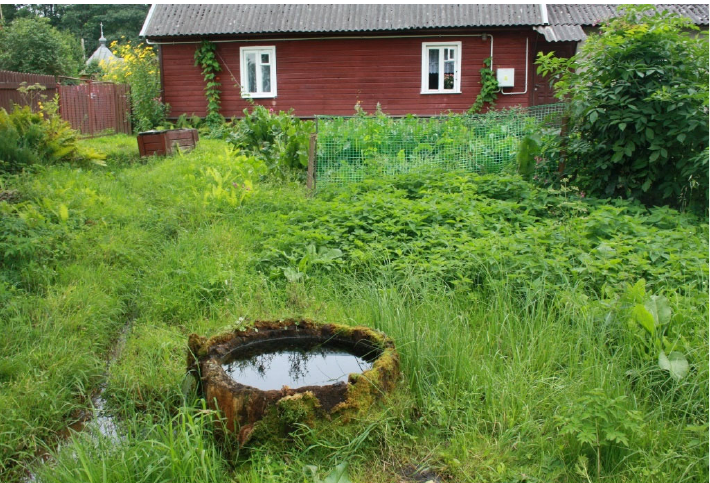
Figure 5. Artificial limnocrene created as a result of the outflow being captured by lining (spring No. 11).